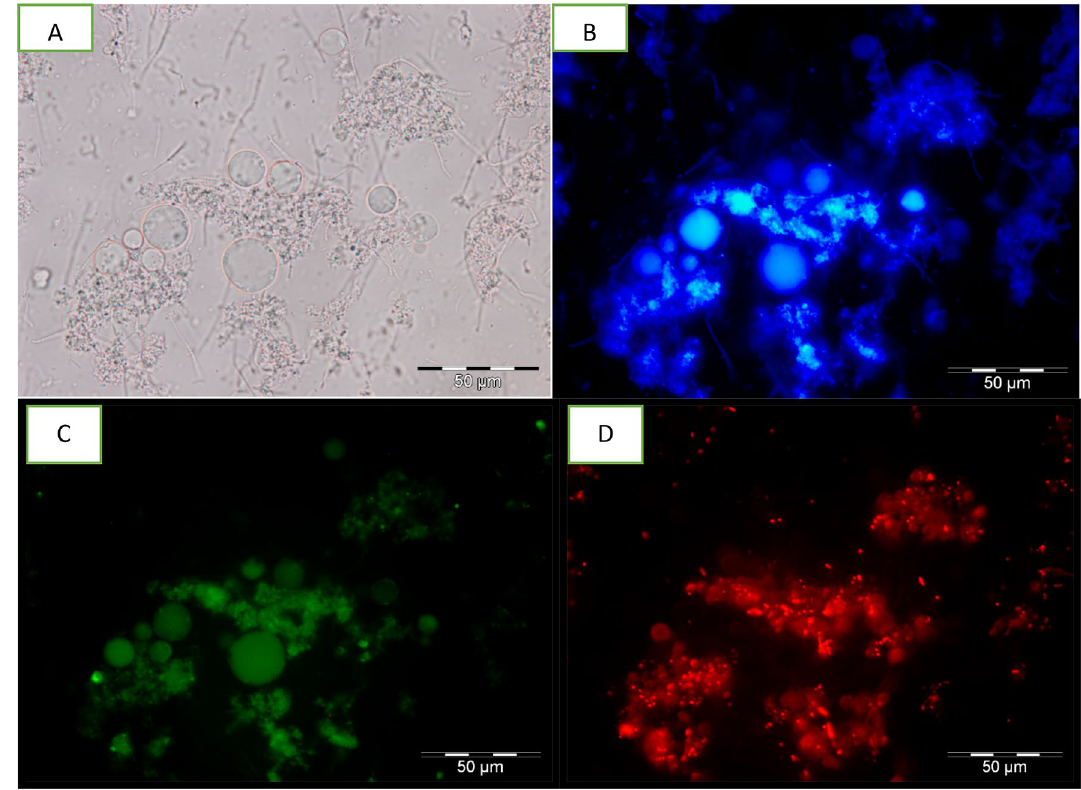
Figure 6. Images of MTZ treated (0.01 mg/ml) Blastocystis sp. undergoing apoptosis viewed under epifluorescent microscope; ( A ) Bright field; ( B ) stained using Hoechst stain; ( C ) [stained using FITC Annexin (V); ( D ) stained using Propidium Iodide.